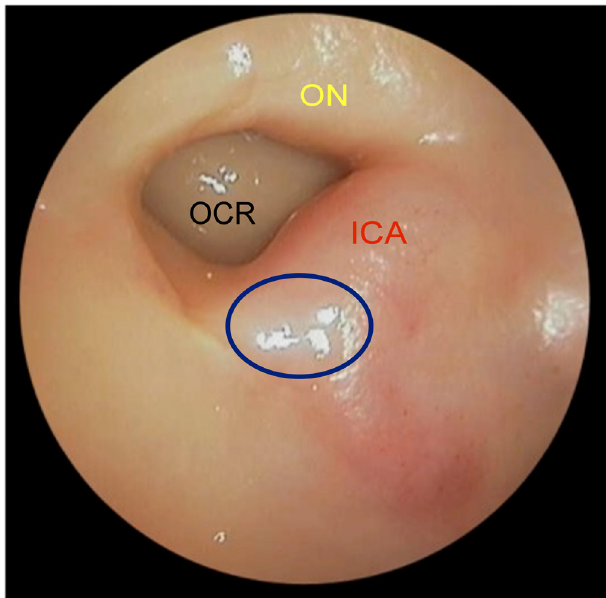
Figure 1. Endoscopic view of optico-carotid recess (OCR) in a right sphe- noid sinus. The blue circle encloses the area of dehiscence. ON = optic nerve. ICA = internal carotid